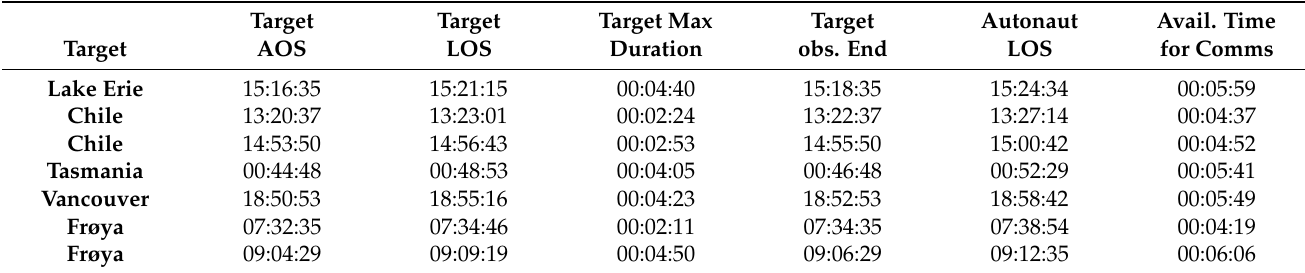
Table 3. Simulations of target observations and communication windows to the AutoNaut. Target Target Target